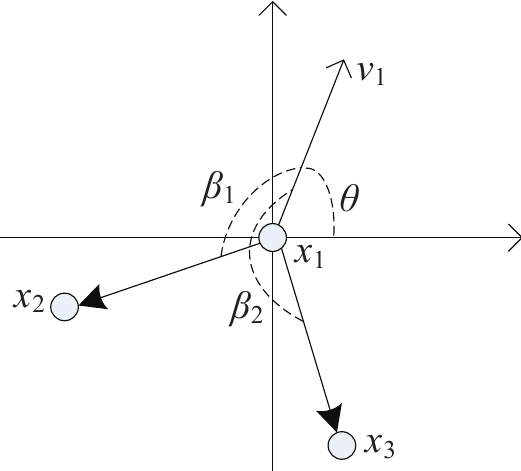
Figure 2. Angle of resolvable group target structure. The node x 1 is a root and also parent node of nodes x 2 and x 3 . Target x 1 moves with velocity vector v 1 , where the angle is θ against x -axis. Besides, the angle of the child node x 2 and its parent x 1 is β 1 . Similarly, the angle between nodes x 1 and x 3 is β 2 . That is, the angle β ( s , d ) between the velocity vector v s of the group targets and the position vector v d between the parent and child nodes remain constant against time. This can be illustrated by Figure 3. Let the formation be three nodes: x 1 , x 2 and x 3 , where x 1 is parent node and x 2 and x 3 are two child nodes. If the formation moves from Point A to B and keeps a fixed shape, two conditions should be met. First, the three nodes are with the same velocites. Second, the angle between two vectors, i.e., velocity vector of parent node x 1 and position vector between parent node and child nodes, should be remain unchanged. For instance, the angle β shown in Figure 3. Thefore, we assumed the angle β ( s , d ) is constant for a fixed formation.